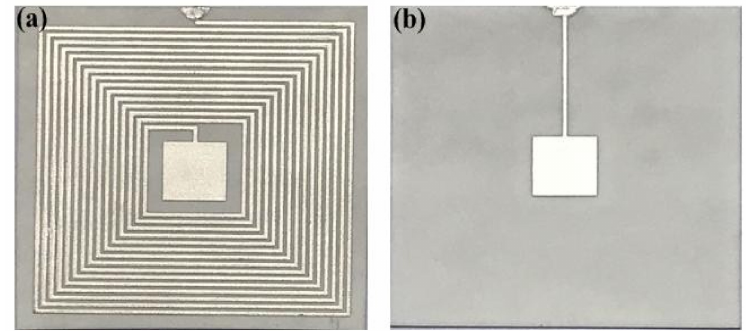
Figure 4. Sensor image. ( a ) Top view image; ( b ) bottom view